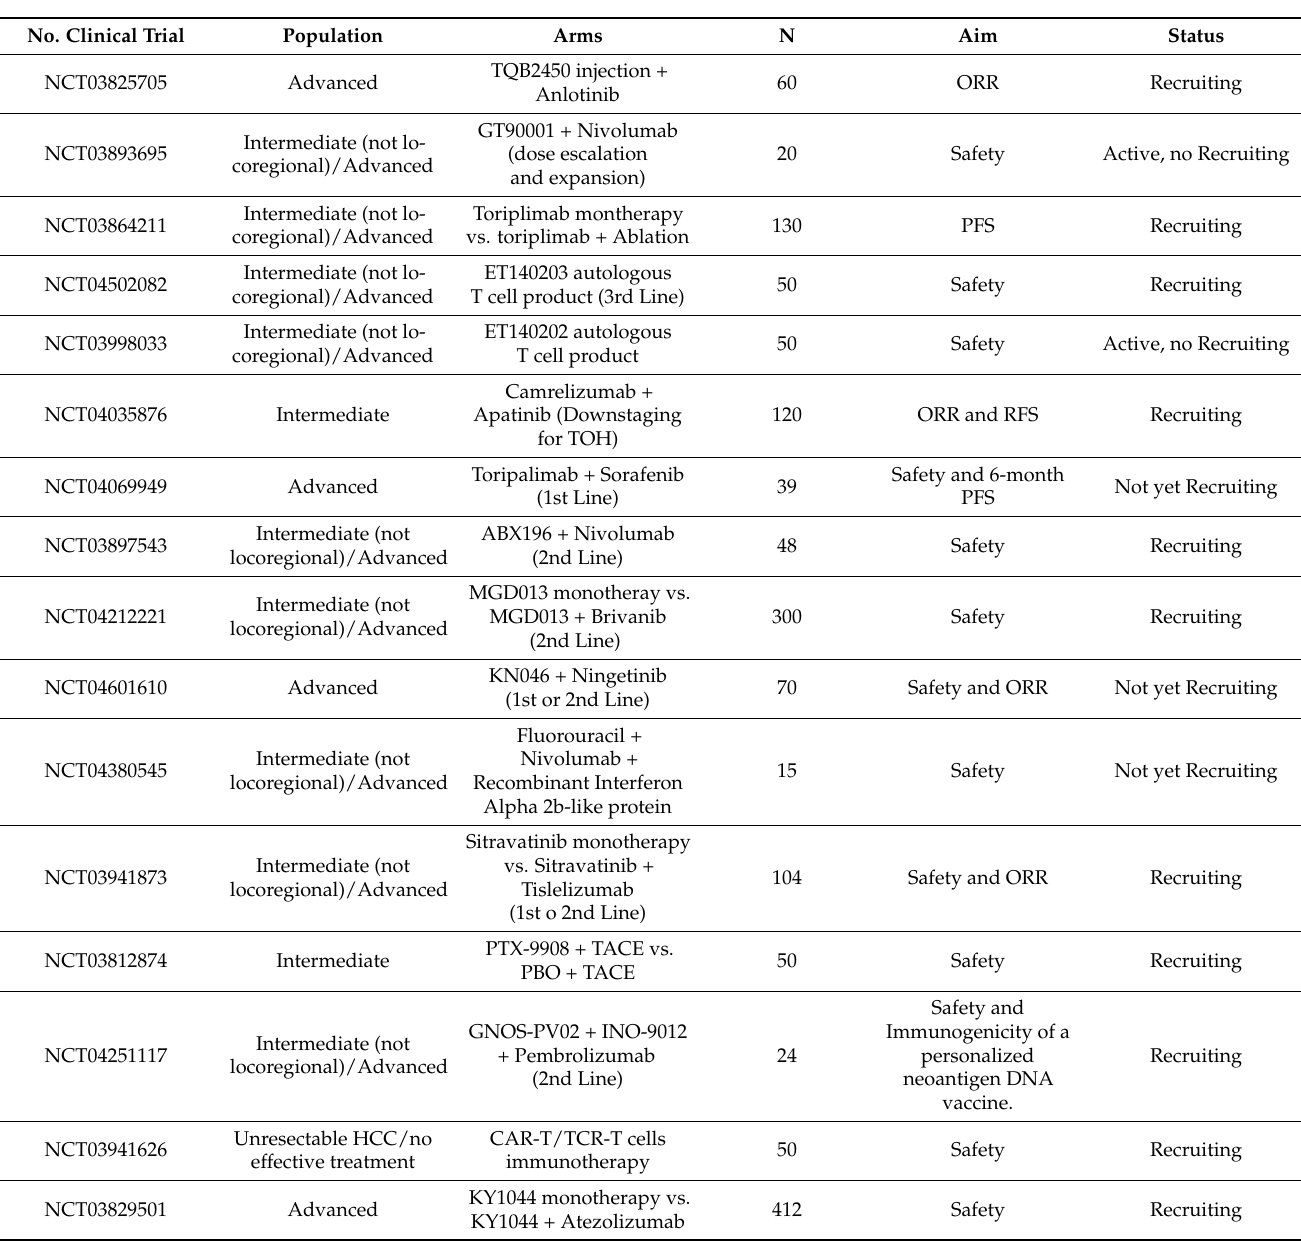
AFP > 400 and 16.8 months for patients with AFP ≤ 400 ng/mL. In this study high baseline levels of plasma TGF- β 1 and E-Cadherin have also associated with poor outcome and